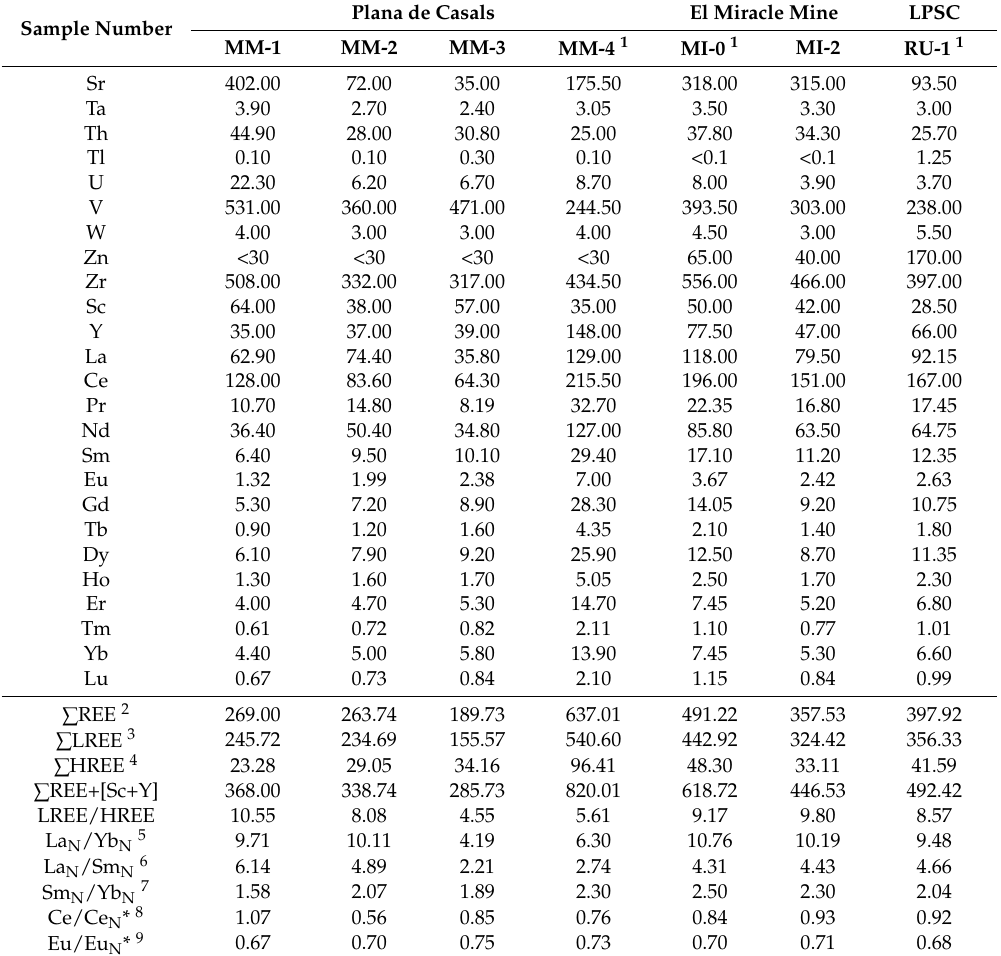
Figure 5. Whole rock SiO 2 -Fe 2 O 3 -Al 2 O 3 +TiO 2 ternary plot of the studied bauxitic samples; bauxite classification fields are after [22]. 4.2. Mineralogy 4.2.1. Mineralogical and Textural Characteristics and Classification of CCR Bauxites Powder-XRD analysis revealed that the studied bauxitic samples are mainly composed of phyllosilicates, Fe-oxides, Al-oxyhydroxides, Ti-oxides, as well as calcite in certain quantities (Table 3). The most abundant mineral is kaolinite (38–96 wt %). Hematite is the only mineral of the Fe-oxide and Fe-hydroxide-groups detected and is present in all samples (traces to 27 wt %), as are the Ti- oxides anatase (traces) and rutile (traces to 5 wt %). Moreover, two samples (namely MM-1 and MI- 0) contain significant amounts of boehmite [γ-AlO(OH)] (23–33 wt %) and diaspore [α-AlO(OH)] (6– 8 wt %). It is worth noting the absence of gibbsite in all the analyzed samples. In samples MI-1B, MI- 2 and RU-1, calcite has been detected (traces to 26 wt %). Furthermore, sample RU-1 also contains 32 wt % of nacrite.